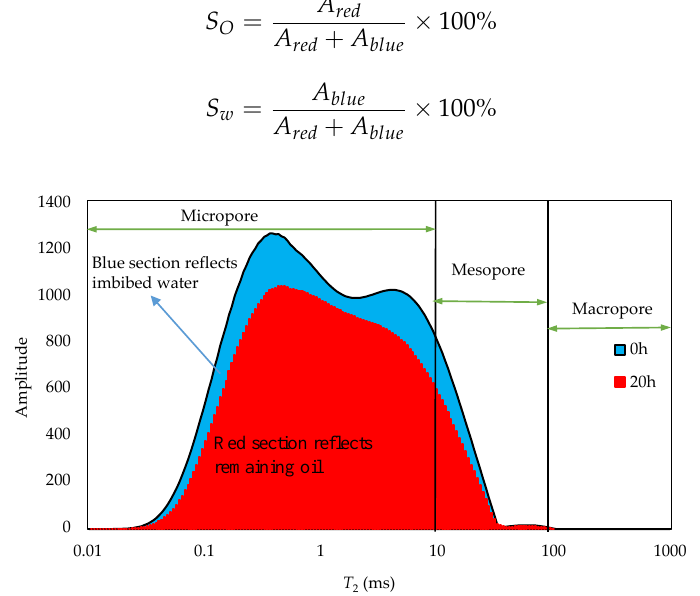
Figure 5. Schematic diagram for analyzing the oil and water distributions in pores.